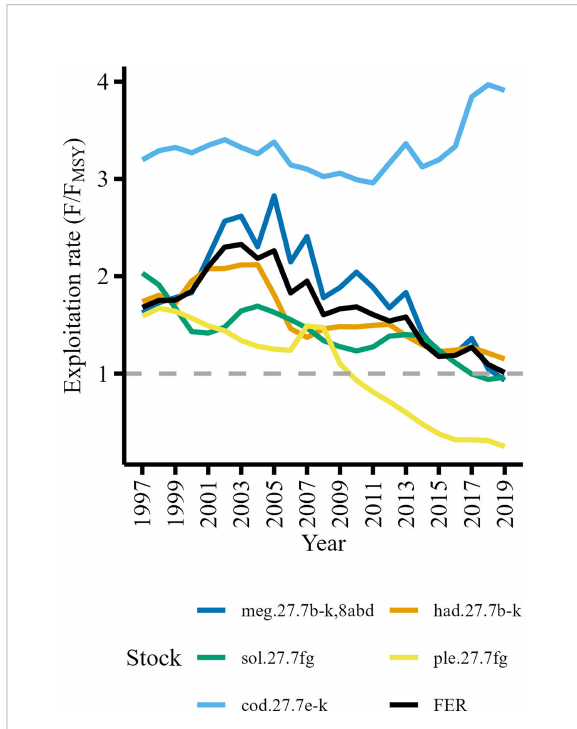
FIGURE 2 Fishing exploitation rates of commercially important Celtic Sea demersal stocks. The mean fi shing exploitation rate (FER) represented by the black line is the catch weighted mean of haddock (had.27.7b-k), megrim (meg.27.7b-k8abd), plaice (ple.27.7fg), and sole (sol.27.7fg) exploitation rates. The grey dashed line delineates the upper threshold for a sustainably exploited stock (F/F MSY ≤